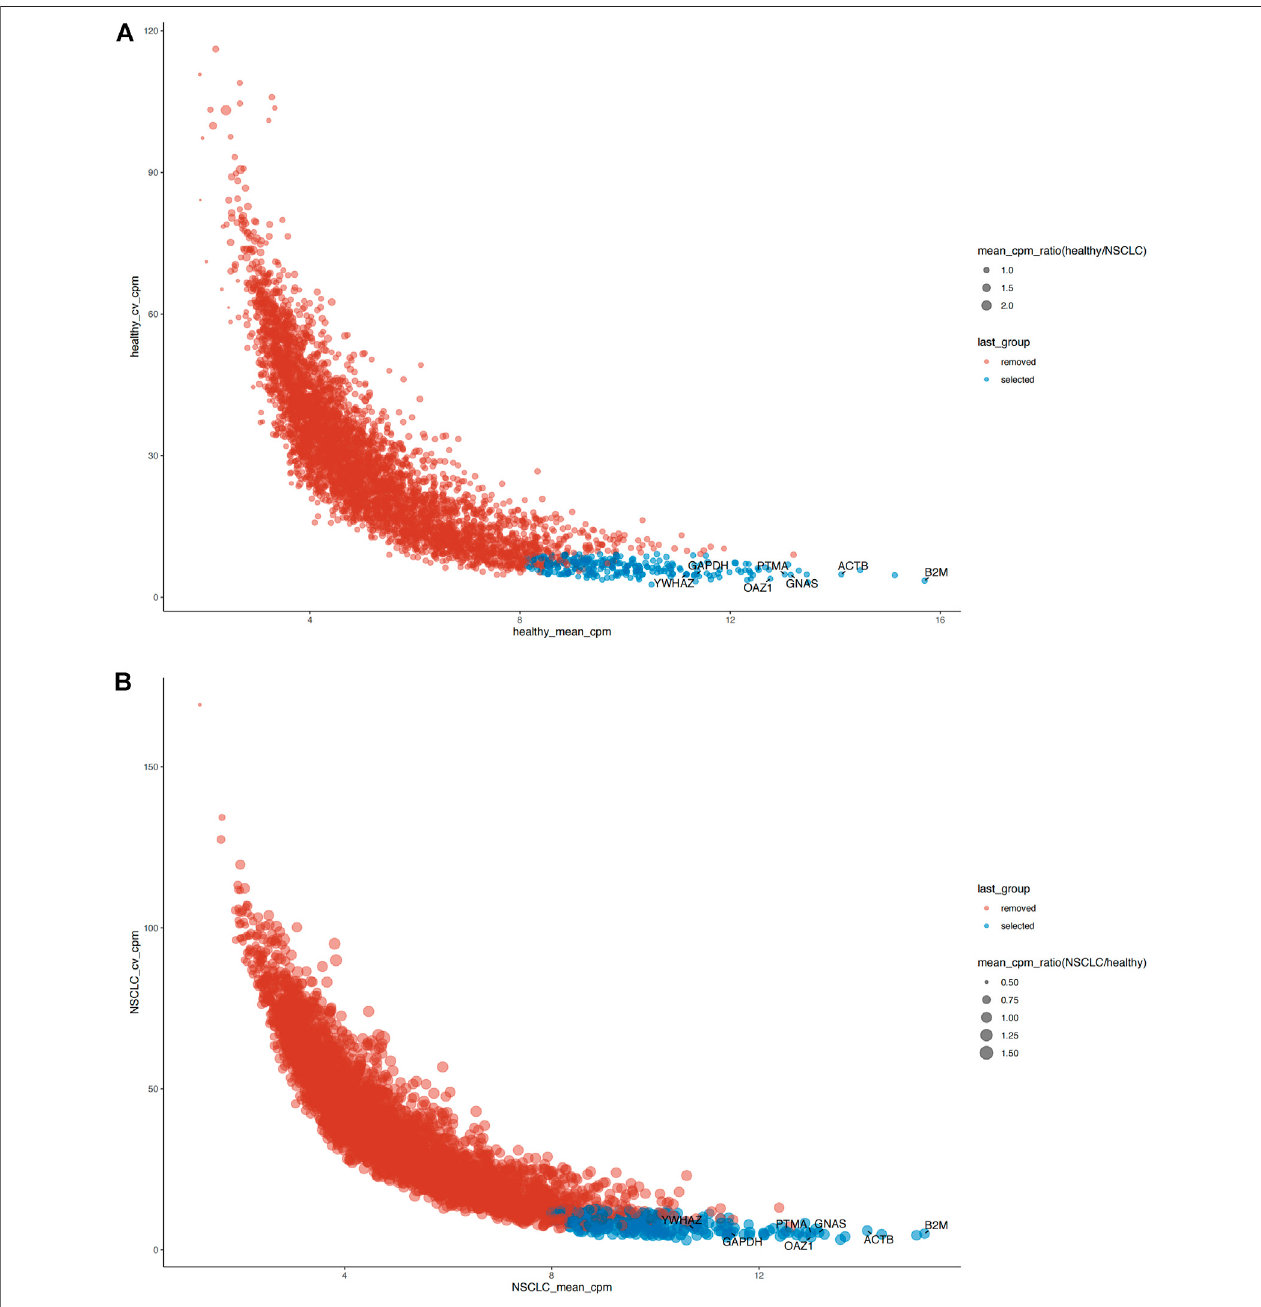
FIGURE 3 | The veri fi cation of expression stability of seven candidate reference genes of platelet in another data set (GSE89843). (A) Seven candidate reference genes all expressed stably in the platelet sequencing data from 377 healthy individuals. (B) Seven candidate reference genes all expressed stably in the platelet sequencing data from 402 NSCLC patients. Blue: selected (stable expression), red: removed (unstable expression).